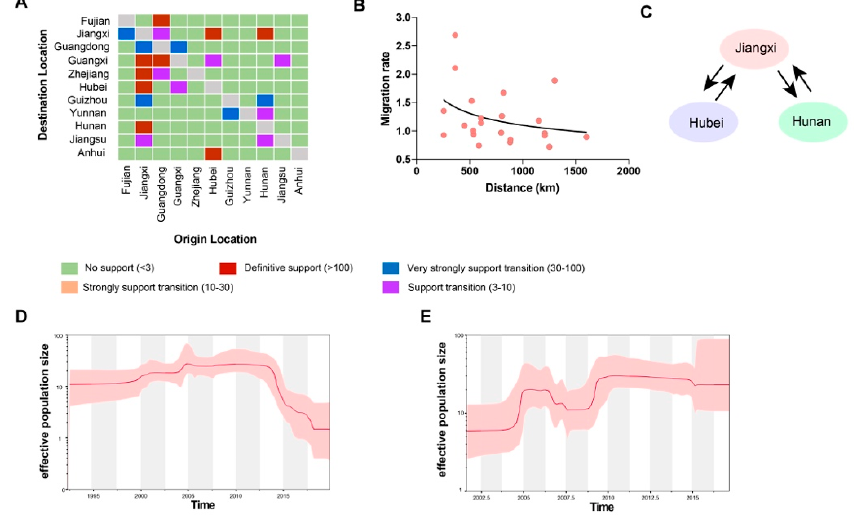
Figure 4. Evolutionary dynamics of H6Nx influenza viruses and level of Bayes factor support for each transmission route. ( A ) The transmission of H6Nx influenza viruses. The left and the right panels display the level of Bayes Factor (BF) support for each of the transmission routes considered for H6Nx influenza viruses. The x -axis represents the origin location and the y -axis represents the destination. ( B ) Among-province virus lineage transition rates (supported with Bayes factor > 3) decrease with geodesic distance between provinces for H6Nx influenza viruses. ( C ) The transmission routes of H6 subtype viruses in Jiangxi, Hunan, and Hubei provinces. Bayesian Skyline plot of HA genes of prevailing H6N2 and H6N6 influenza viruses in China. A Bayesian Skyline analysis of HA gene of H6N2 viruses ( D ) and H6N6 viruses ( E ) to display changes in the effective population size over time. The solid red line indicates the median value and the shaded red area represents the 95% highest posterior density of genetic diversity